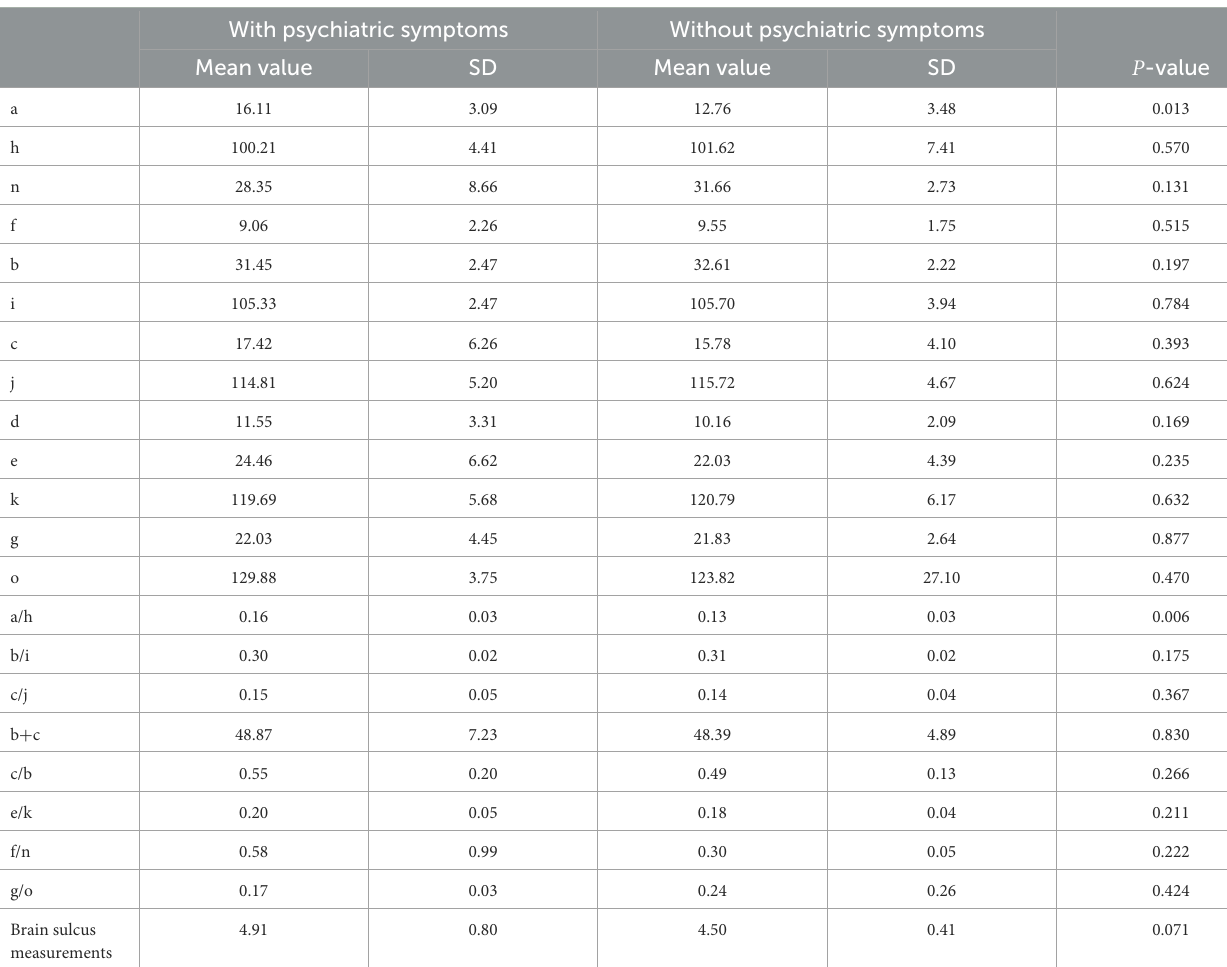
TABLE 5 Linear measures of brain atrophy between WD patients with and without psychiatric symptoms. With psychiatric symptoms Without psychiatric symptoms Mean value SD Mean value SD P -value 16.11